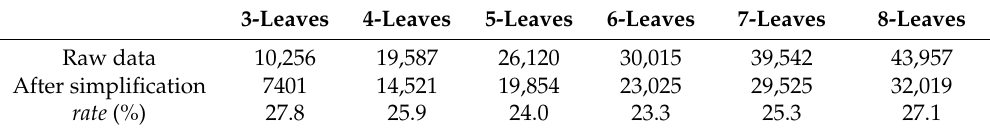
Table 1. Simplification rate of maize from the 3-leaves stage to the jointing stage.